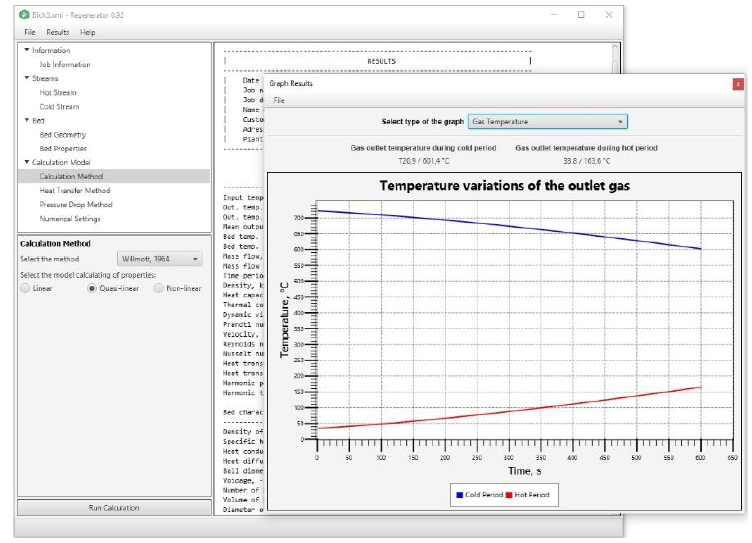
Figure 6. Screenshot of created software.